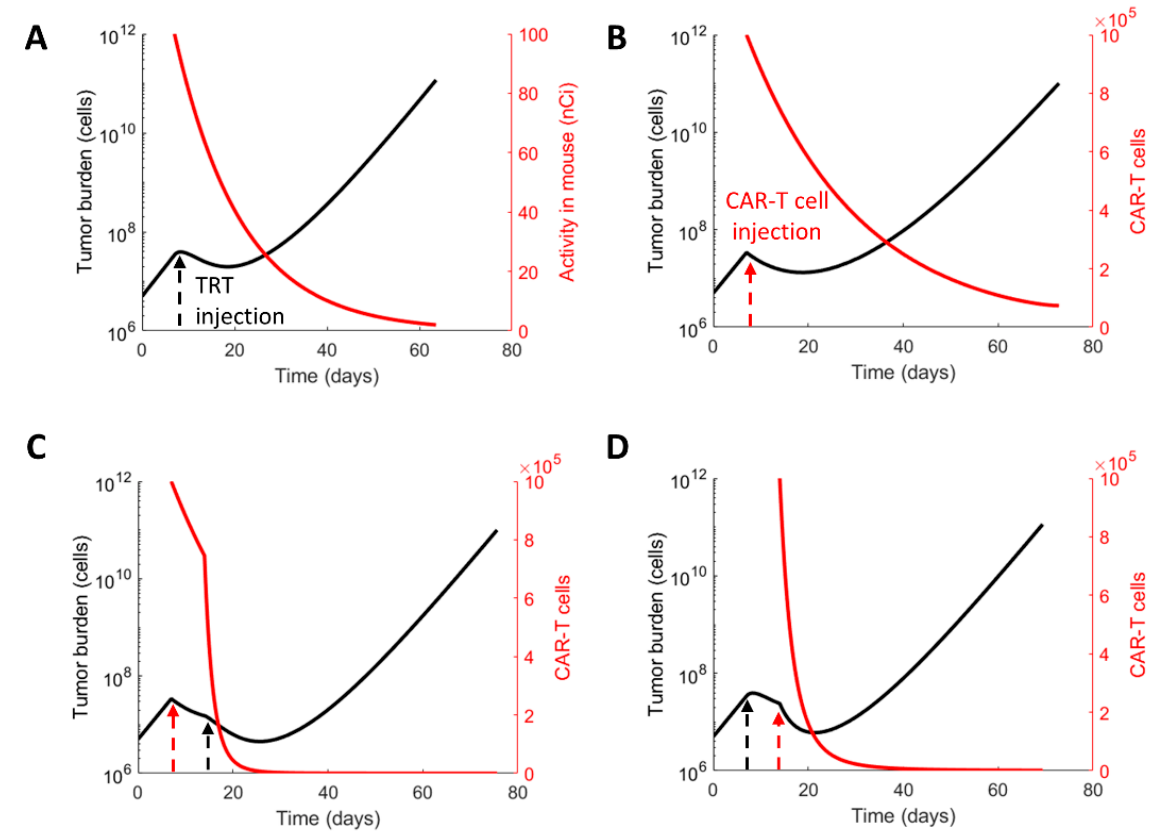
Figure 3. Model simulations of TRT and CAR-T therapy alone and in combination. Monotherapy simulations of ( A ) TRT treatment (black arrow, A 0 = 100 nCi) or ( B ) CAR-T cell (red arrow, N C ( t = 7 ) = 1 × 10 6 ) administered on day t = 7. Combination treatment simulations with ( C ) CAR-T cells on day t = 7 followed by TRT on day 14 and ( D ) TRT on day 7 followed by CAR-T cells on day 14. The mathematical model predicts the tumor growth, radionuclide decay, and CAR-T cell populations over time. Table 2. Simulated measures of tumor response to individual and combination therapies . The first therapy is given seven days post tumor initiation. For the combination therapy, the second ther- apy is given seven days following the first therapy.